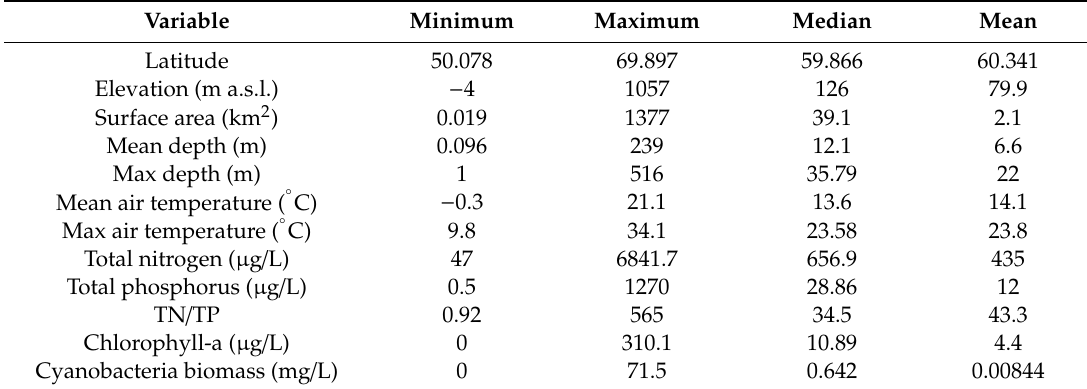
Table 2. Distribution of variables across the